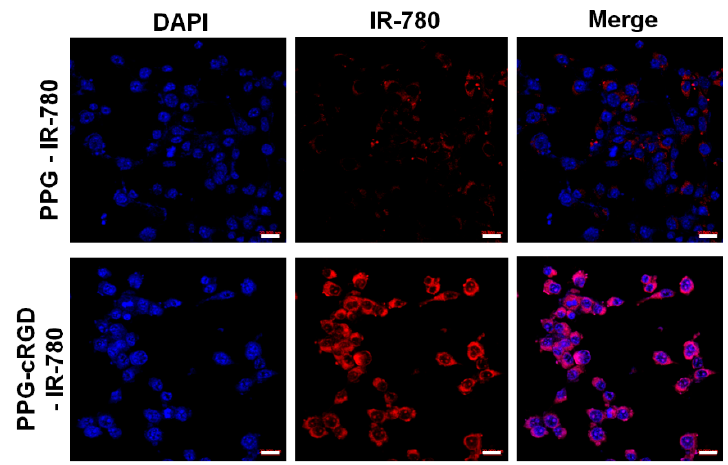
Figure 6. Confocal images of intracellular uptake of PPG-IR-780 NPs and PPG-cRGD-IR-780 NPs after 4-h incubation. The nucleus was stained with DAPI (blue). Scale bar: 20 µm.